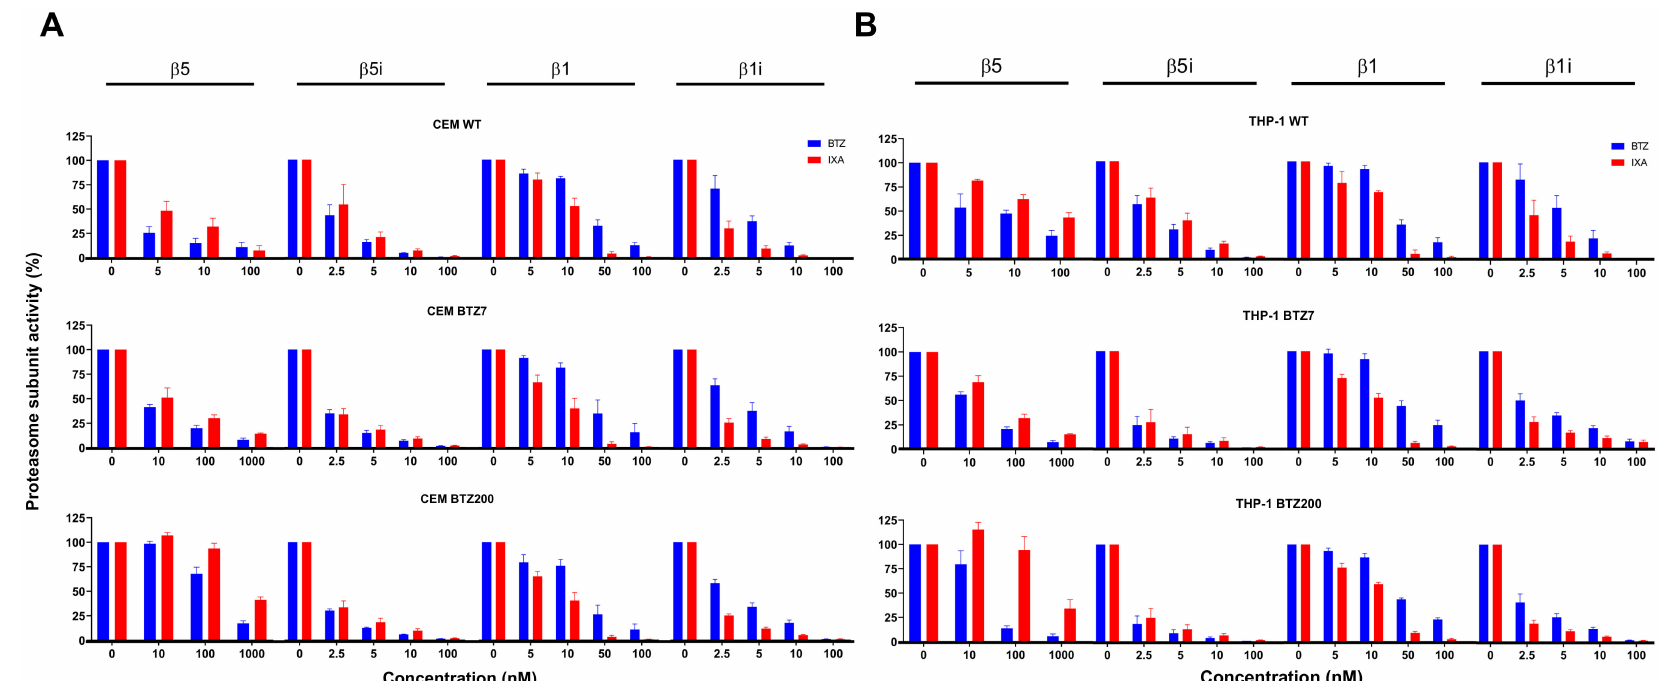
Figure 1. Ixazomib (IXA) vs. Bortezomib (BTZ) inhibition profile of proteasome subunit activity in CEM (acute lymphoblastic leukemia, ALL) and THP-1 (acute myeloid leukemia, AML) cells and their low/high BTZ-resistant sublines. β 5-, β 5i-, β 1-, and β 1i-associated catalytic activity in CEM ( A ) and THP-1 ( B ) cell extracts of wild-type (WT), BTZ7 (low level BTZ resistance), and BTZ200 (high level BTZ resistance) was assessed in the absence (control) or presence of increasing concentrations of IXA or BTZ. Results depicted represent the mean ± SEM of three separate